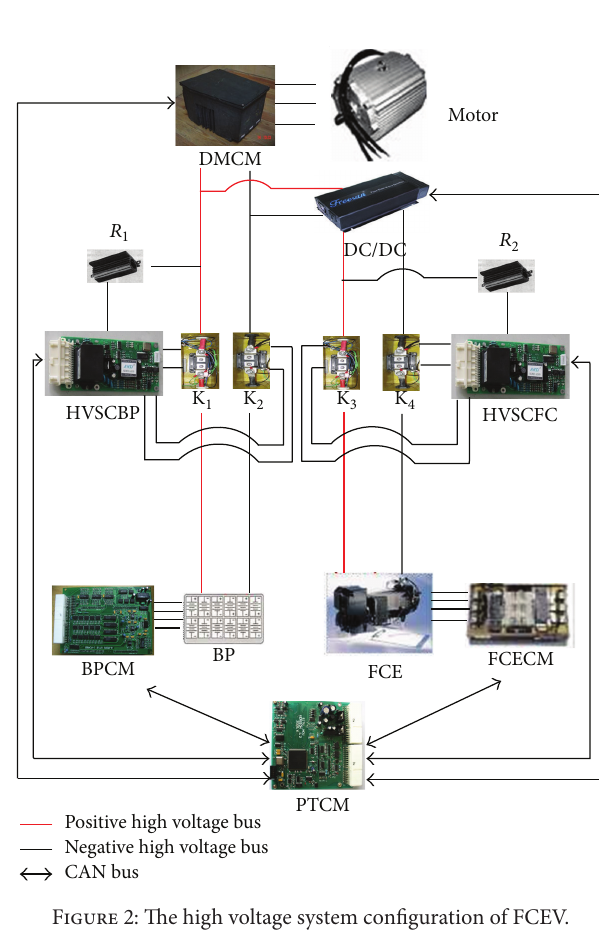
Figure 2: The high voltage system configuration of